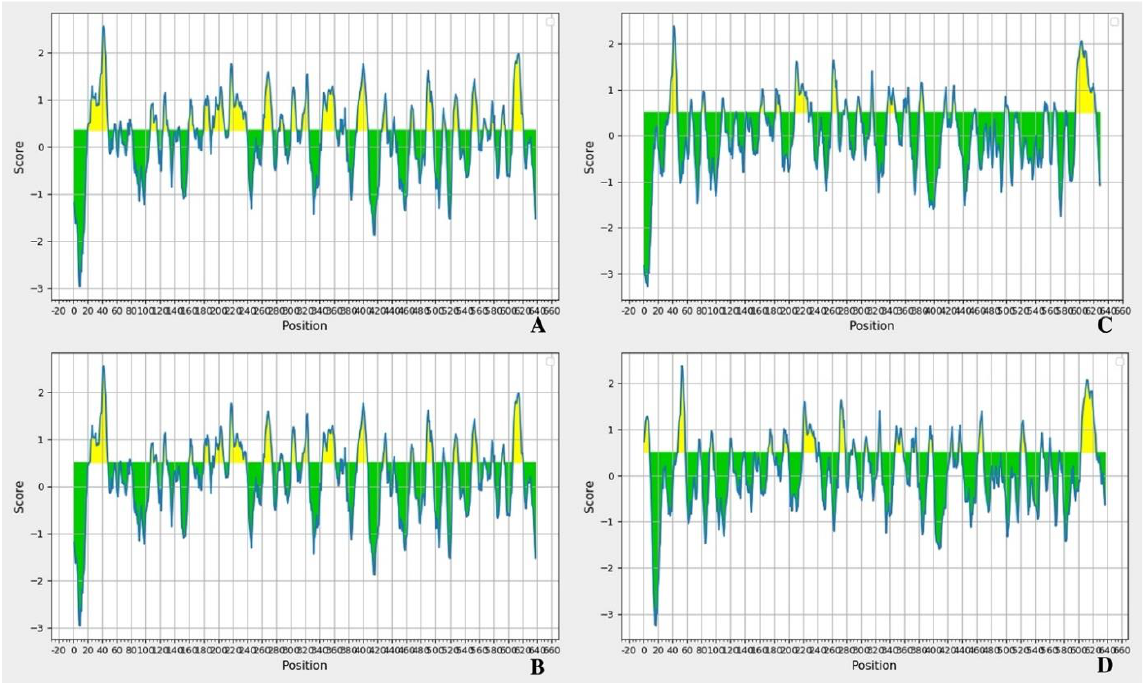
Figure 4. Epitope modeling using amino acids sequences of L. borgpeterseni VM proteins applied at the Bepipred Linear Epitope Prediction tool [51]. Legend: ( A ) (M6BGF1), ( B ) (Q04V07), ( C ) (Q04NE0) and ( D ) (Q04T47). Better visualization of the figures can be found at the Supplementary File as well as the figures related to L. interrogans LAI epitope modeling.